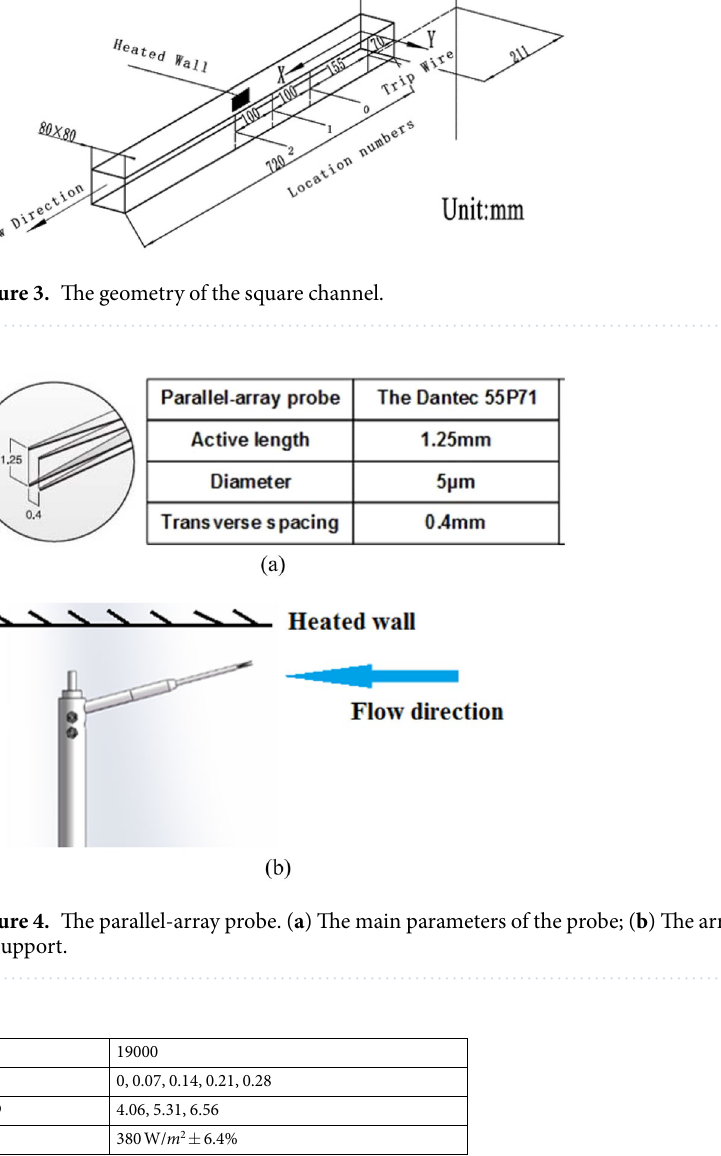
Table 1. Experimental parameters of the square channel.